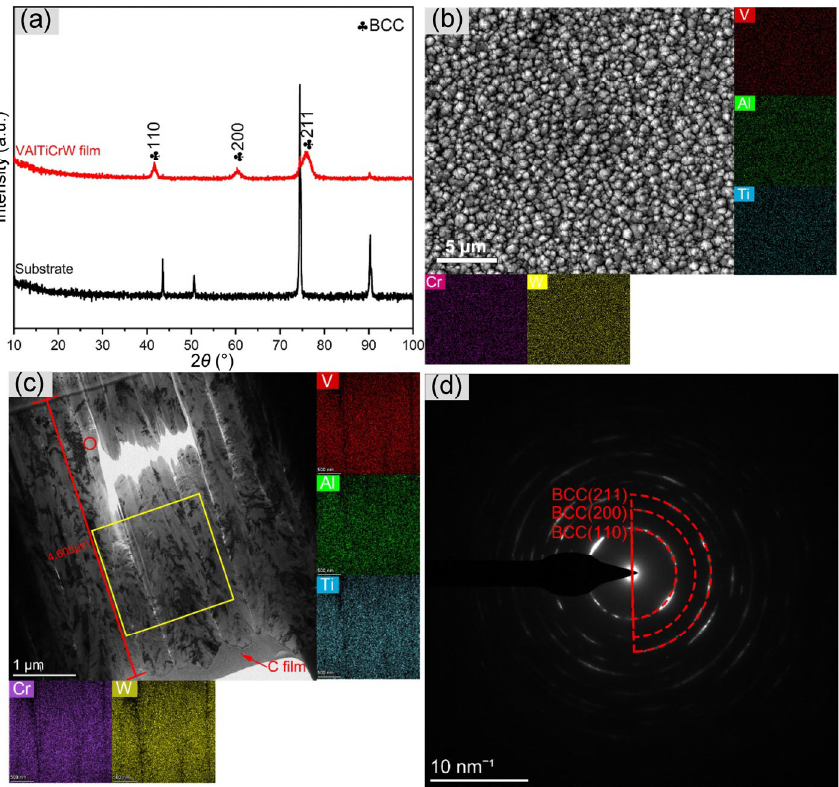
Fig. 1 XRD diffraction patterns (a), surface SEM image (b), and cross-sectional TEM image (c) of as-prepared VAlTiCrW film, SAED pattern in the red circle